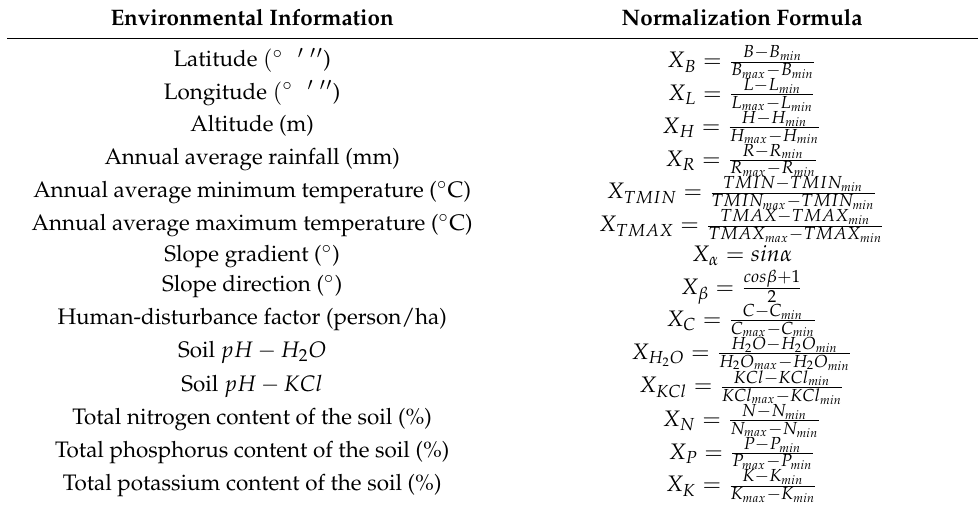
Table 1. Normalization formulas of the 14 environmental information